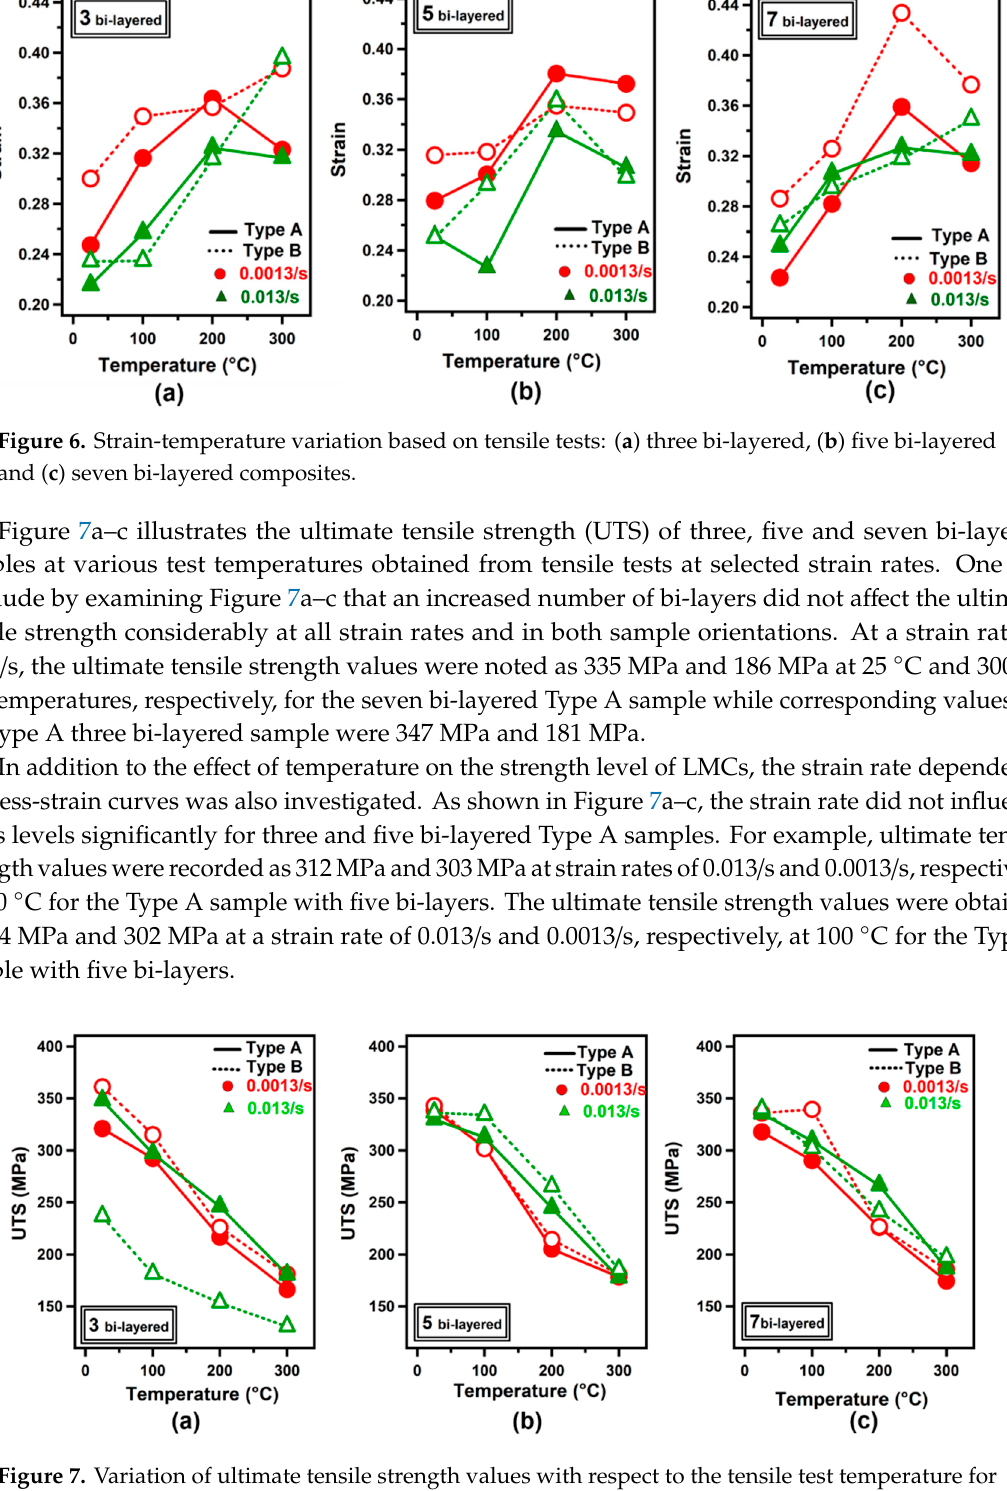
Figure 7. Variation of ultimate tensile strength values with respect to the tensile test temperature for ( a ) three bi-layered, ( b ) five bi-layered and ( c ) seven bi-layered LMCs. Characterization of LMC samples was also carried out by means of bulge test analyses. LMC